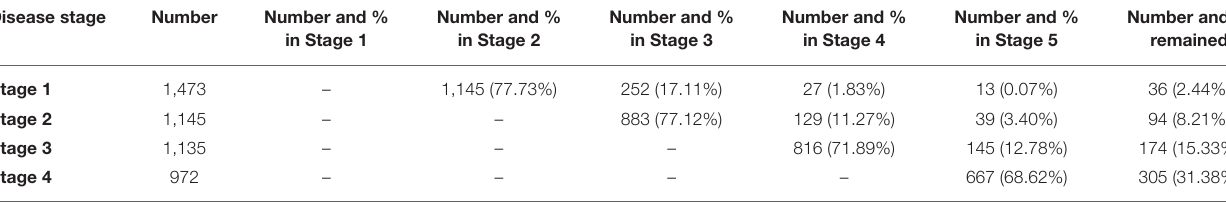
TABLE 1 | Number and proportion of patients who reached each stage during the disease progression. Disease stage